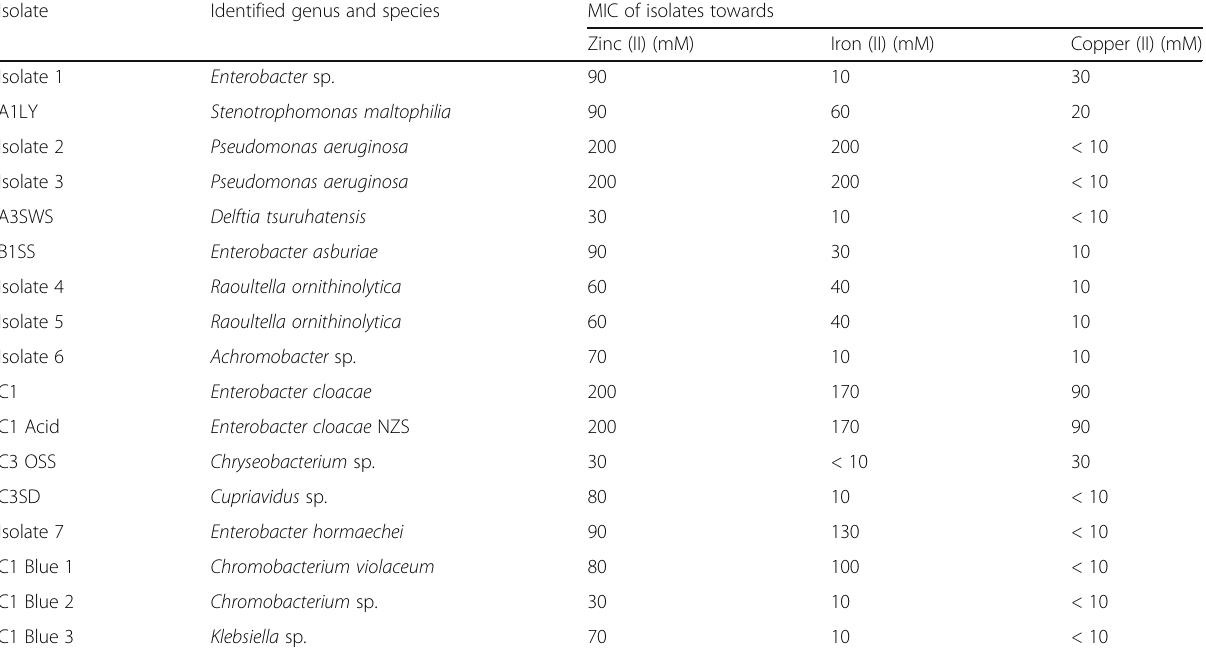
Table 2 Screening of metal tolerant bacterial isolates through their minimal inhibition concentration (MIC) in LB media containing 3 different metals